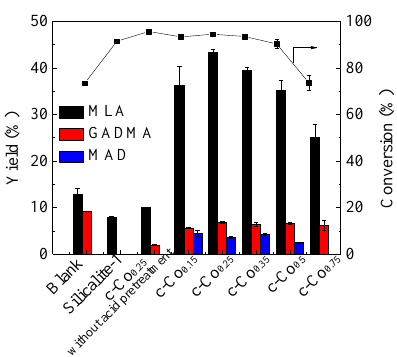
Figure 3. Catalytic conversion of HFCS-55 over c-Co x . Reaction conditions: HFCS-55, 0.06 g; metha- nol, 6 mL; catalyst, 0.03 g; 180 °C; 18 h.